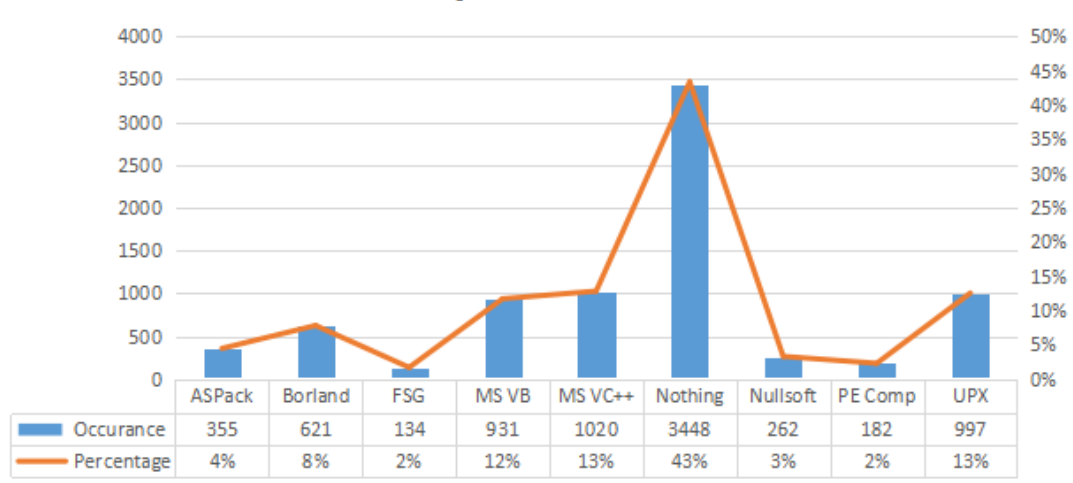
Figure 2. Top 10 packers from 8637 packers. 199